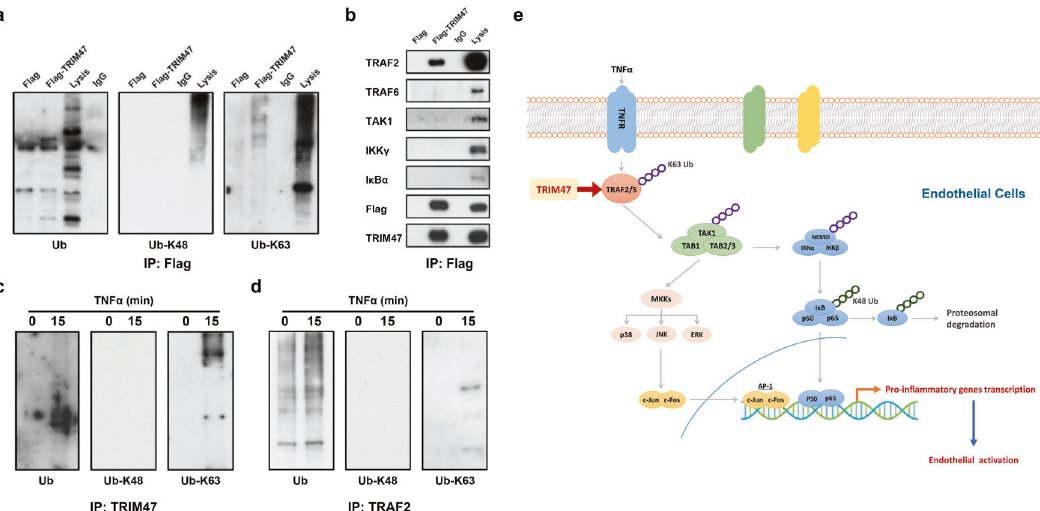
Fig. 7 TRIM47 mediates K63-linked ubiquitylation and interacts with TRAF2. HUVECs were transfected with Flag or Flag-TRIM47 plasmid for 48 h and treated with TNF α for 15 min. Whole-cell lysates were immunoprecipitated with Flag antibody, and the precipitates were immunoblotted with ( a ) Ub, Ub-K48, Ub-K63, ( b ) TRAF2, TRAF6, TAK1, IKK γ , and I κ B α antibodies ( n = 3). HUVECs were treated with 10 ng/ml TNF- α for 0 and 15 min. Cell lysates were then immunoprecipitated using ( c ) TRIM47 and ( d ) TRAF2 antibodies. Representative images demonstrated the total, K48- and K63-linked ubiquitylation by western blot analysis using the indicated antibodies ( n = 3). e The schematic diagram of the mechanism by which TRIM47 mediates TNF α -induced endothelial activation through promoting endothelial TRAF2-MAPK/NF- κ B pro-in fl ammatory